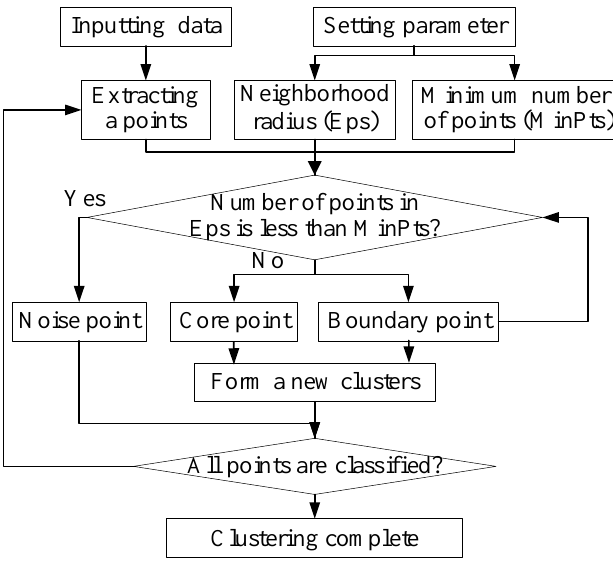
Figure 1. Flow chart of DBSCAN algorithm.